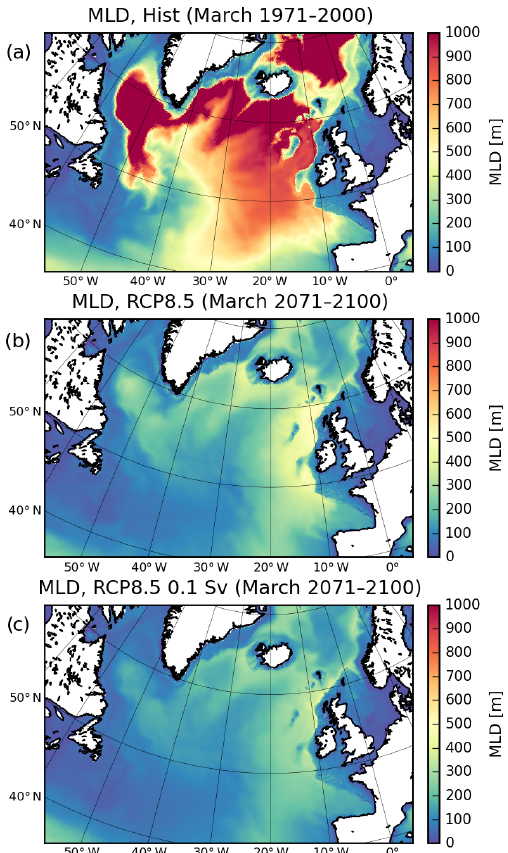
Figure 3. Simulated March mixed layer depth in the